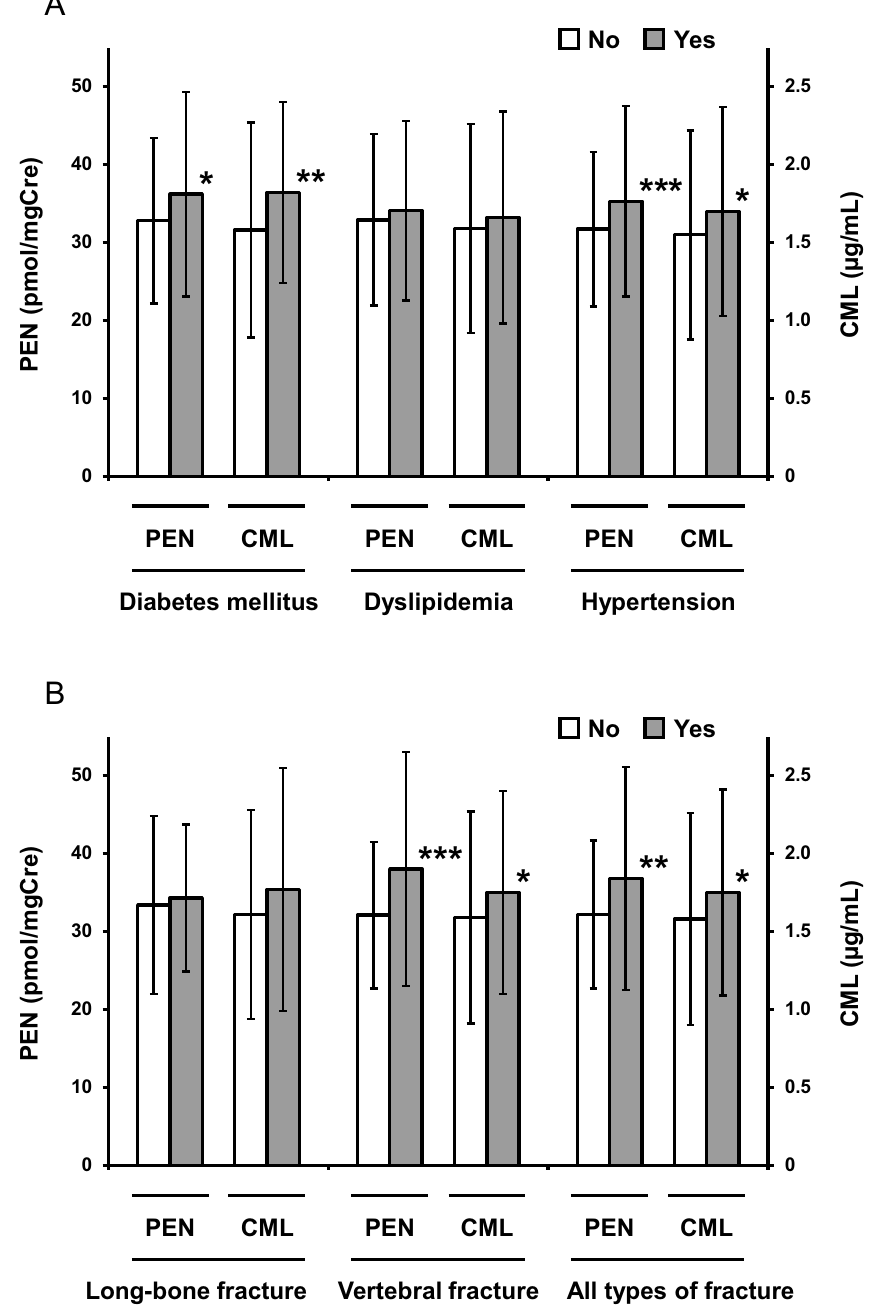
Figure 2. AGE levels according to the presence of co-morbidities and prevalent fractures. Mean ± SD values of PEN (left axis) and CML (right axis) in patients with or without ( A ) co-morbidities and ( B ) prevalent fractures are presented. Asterisks indicate significant differences vs. patients without each disorder evaluated by Student’s t -test (* P < 0.05, ** P < 0.01, and *** P < 0.001). AGE advanced glycation end product, SD standard deviation, PEN pentosidine, CML